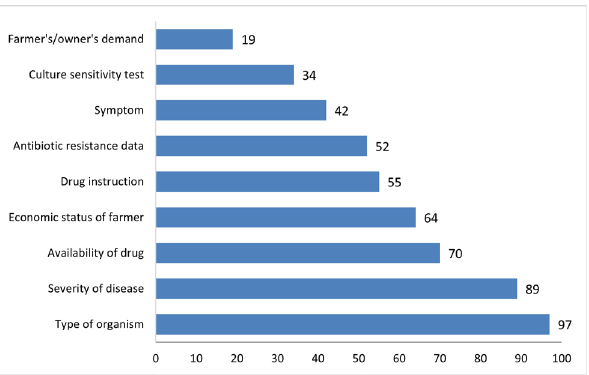
Figure 4: Factors considered by veterinarians during the prescription of